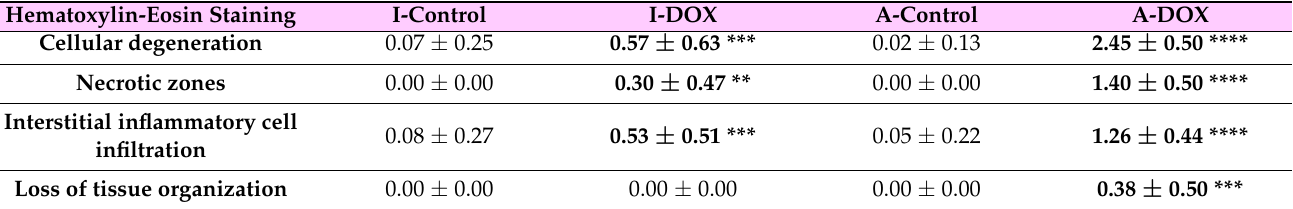
Figure 3. Cardiac histopathology, using light microscopy, of infant DOX-treated ( I-DOX ) and control mice ( I-Control ) and of adult mice exposed to a cumulative dose of 18.0 mg/kg DOX ( A-DOX ) and respective controls ( A-Control ), assessed by hematoxylin and eosin staining. Representative light micrograph from: infant mice controls, showing normal morphology and structure; infant mice given a cumulative dose of 18.0 mg/kg DOX; control adult mice, showing normal morphology and structure; and adult mice given a cumulative dose of 18.0 mg/kg DOX. DOX-treated groups presented large and uncondensed nucleus (yellow arrow), extensive loss of myofibril (white arrow), vacuolization (orange arrow), inflammatory infiltration, (cyan arrow) and vascular congestion (green arrow). Necrotic zones (blue arrow) are evident. Scale bar = 100 µm, n = 3. Images were taken at 40× magnification. Table 2. Semi-quantitative analysis of the morphological parameters (cellular degeneration, necrotic zones, interstitial inflammatory cell infiltration and loss of tissue organization) in the heart of DOX-treated and controls, in adult and infant animals.